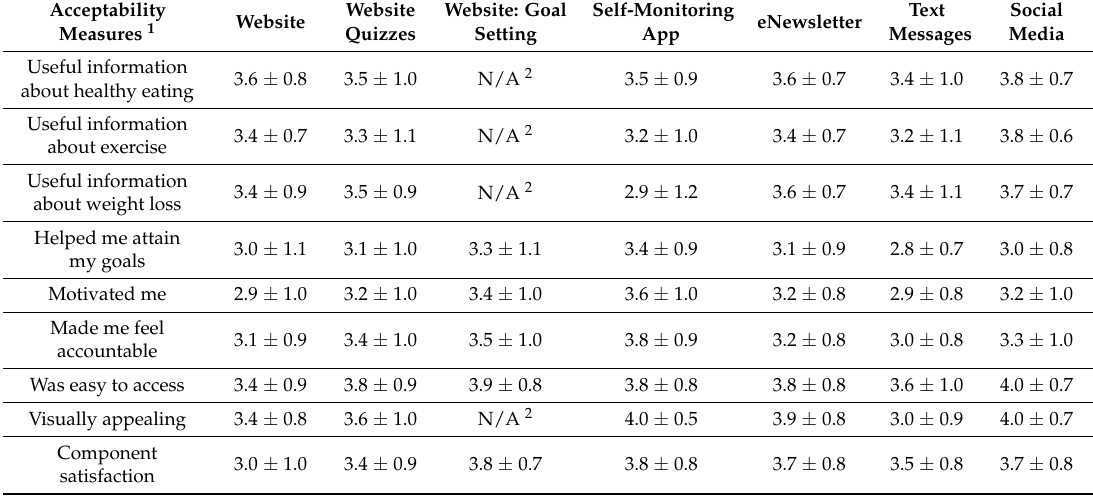
Table 4. Acceptability measures of the Be Positive Be Health e six-month weight loss program